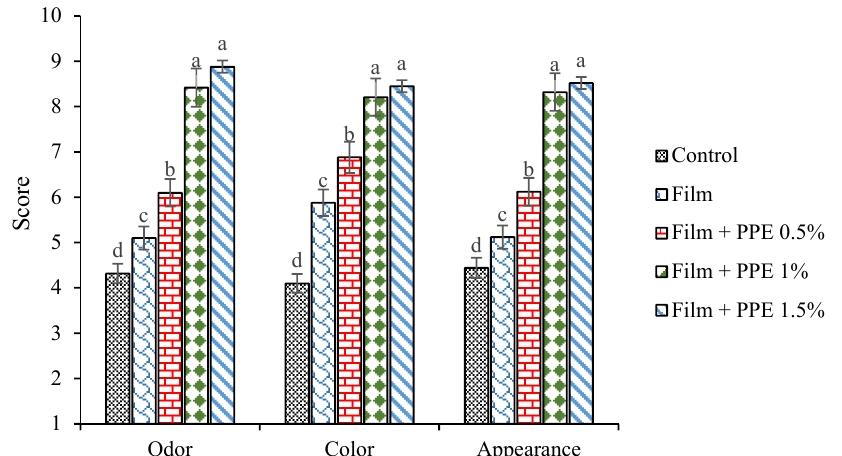
Fig. 7. Sensory attributes (odor, color and overall acceptability) of raw rainbow trout fillets packed in chitosan-ZnO films containing different concentrations of pomegranate peel extract (PPE) during refrigerated storage. Each number is the mean ± standard error taken from different experiments. a–d For each attribute, columns representing different bacterial population are labeled with different letters (P < 0.05)